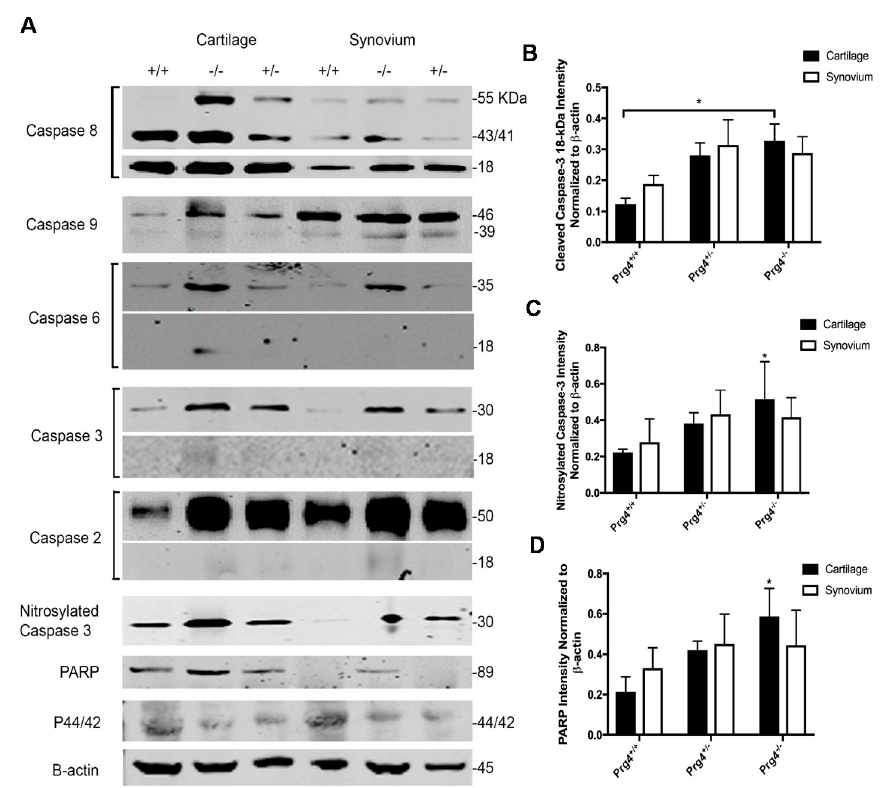
Figure 4. Western blots and densitometry of apoptosis mediators from Prg 4 mutant mice: ( A ) Montage of western blots of extrinsic apoptosis pathway factor (caspase 8), intrinsic pathway factors (caspase 2, 6 and 9), caspase 3, nitrosylated Cys163 neo-epitope of caspase 3, cleaved poly (ADP-ribose) polymerase (PARP) and p44/42 across cartilage and synovium of five Prg 4 − / − , Prg 4 +/ − and Prg 4 +/+ mice. Bands were scanned and normalized to β -actin in the same lanes; ( B ) Densitometry of the cleaved caspase-3 18-kDa band; ( C ) Nitrosylated Cys163 neo-epitope of caspase 3; ( D ) Cleaved PARP across all three Prg 4 genotypes. More apoptosis mediators illustrated in ( B )–( D ) were detected in cartilage from Prg 4 − / − mice than in Prg 4 +/+ littermates, *p<0.05.